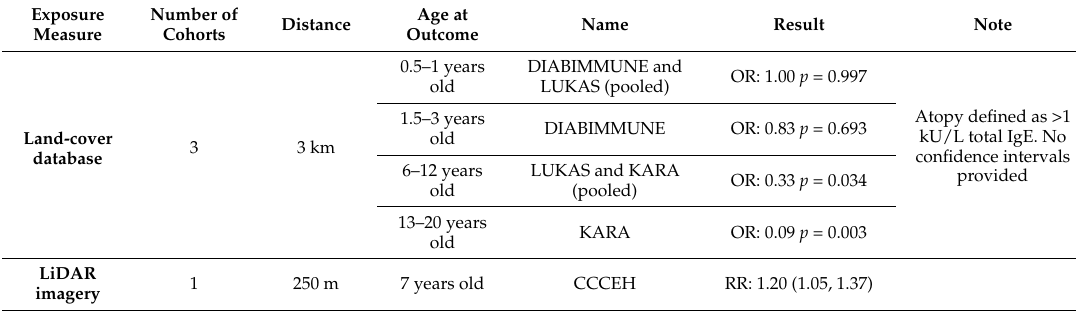
Table 3. Results by exposure